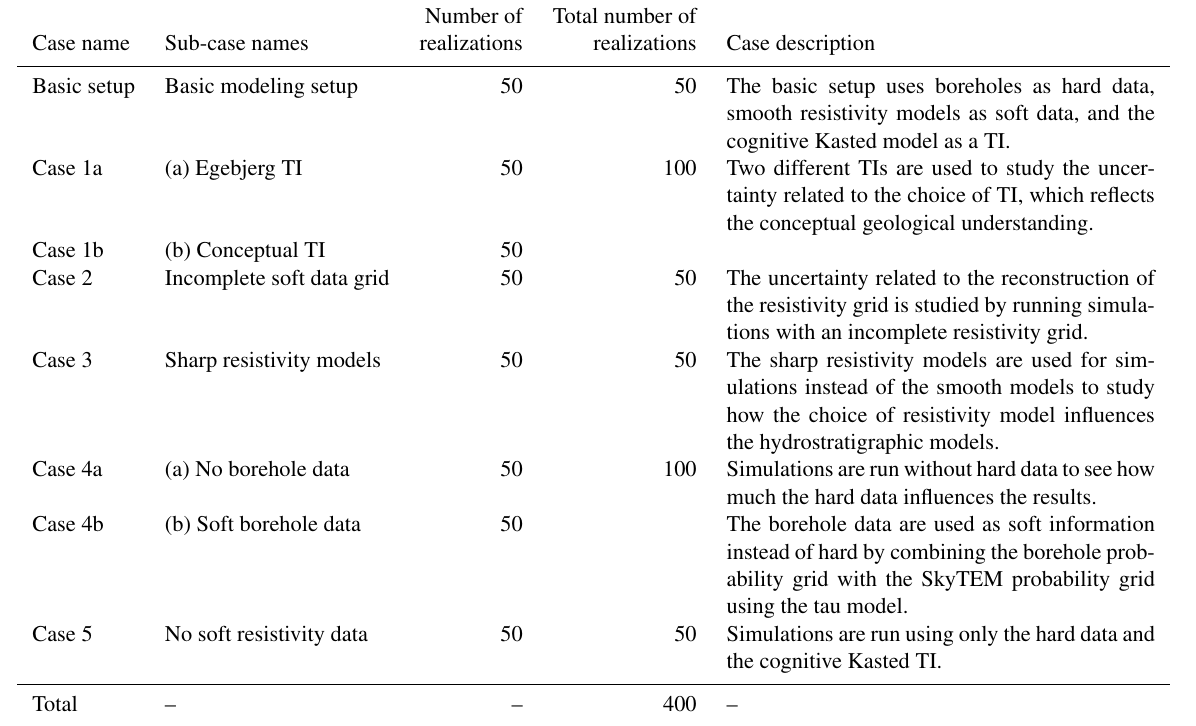
Table 1. An overview table showing information on the MPS cases along with information on the number of realizations for each case or sub-case, and a brief description of each case.